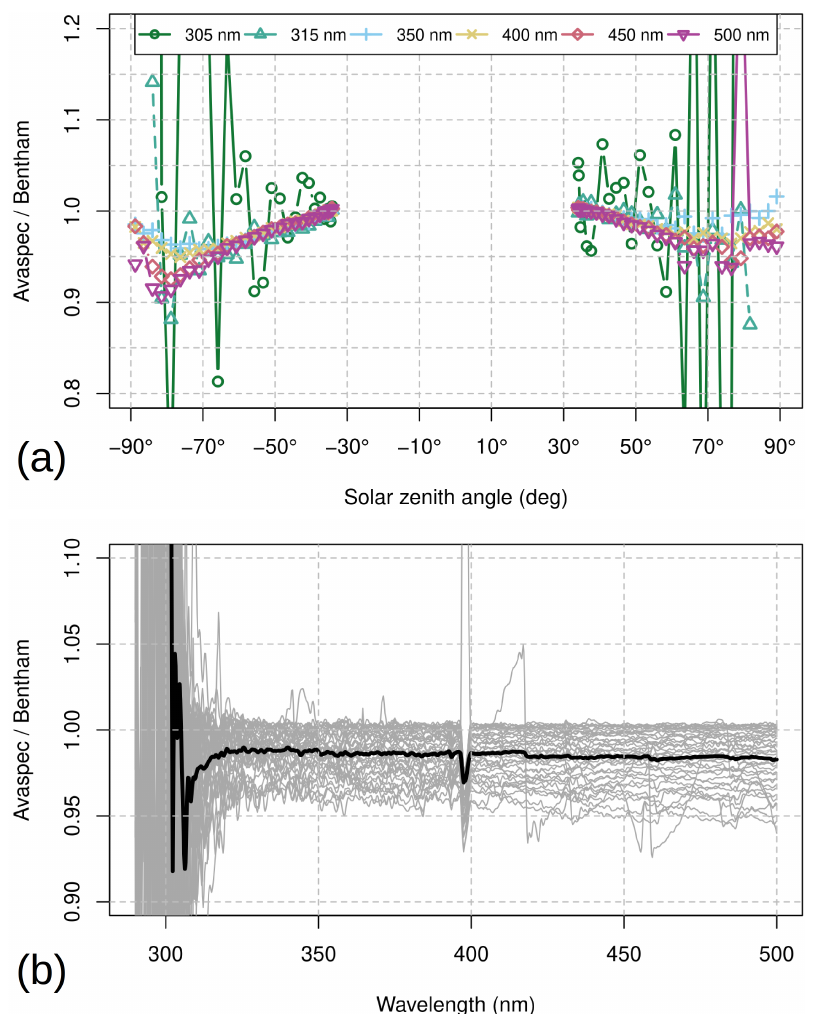
Figure 7. Comparison of the spectra measured on 23 August 2022 by the Avaspec and the Bentham (reference) spectroradiometers. ( a ) Ratio at specific wavelengths as a function of the solar zenith angle (negative values refer to morning, positive to afternoon). ( b ) Ratio of all spectra at SZAs < 70 ◦ (grey lines) and their average (bold line), as a function of wavelength. The dip at about 400 nm is due to two Fraunhofer lines in the solar spectrum, which were not fully compensated for by